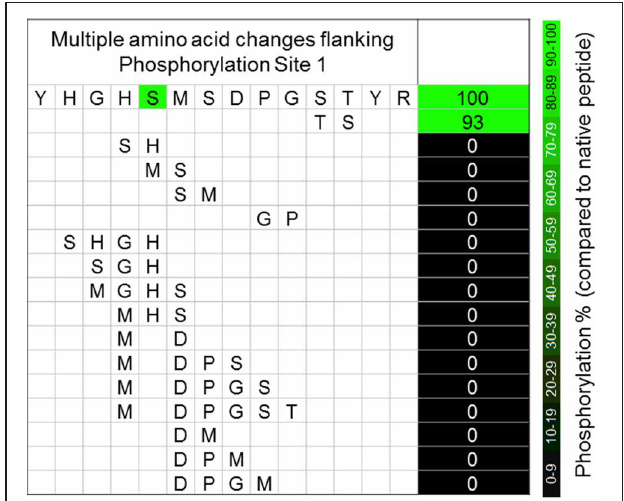
FIGURE 3 | The effects of multiple simultaneous amino acid changes to the sequences flanking phosphorylation site 1 of A. thaliana PDC E1 α . Values are percentage changes compared with the native sequences, and are the means of three technical replicates.